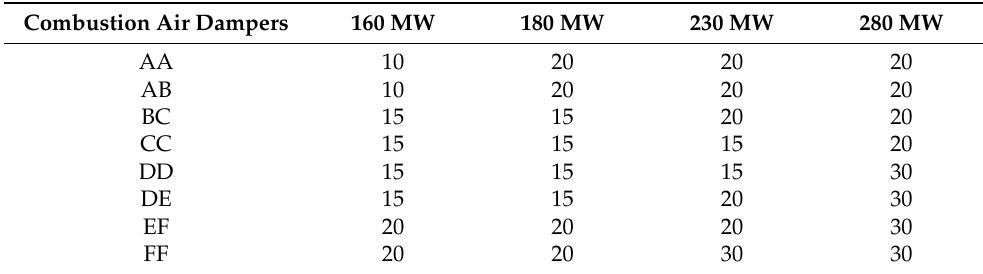
Table 9. The table of optimal air distribution of combustion air under typical load (%).